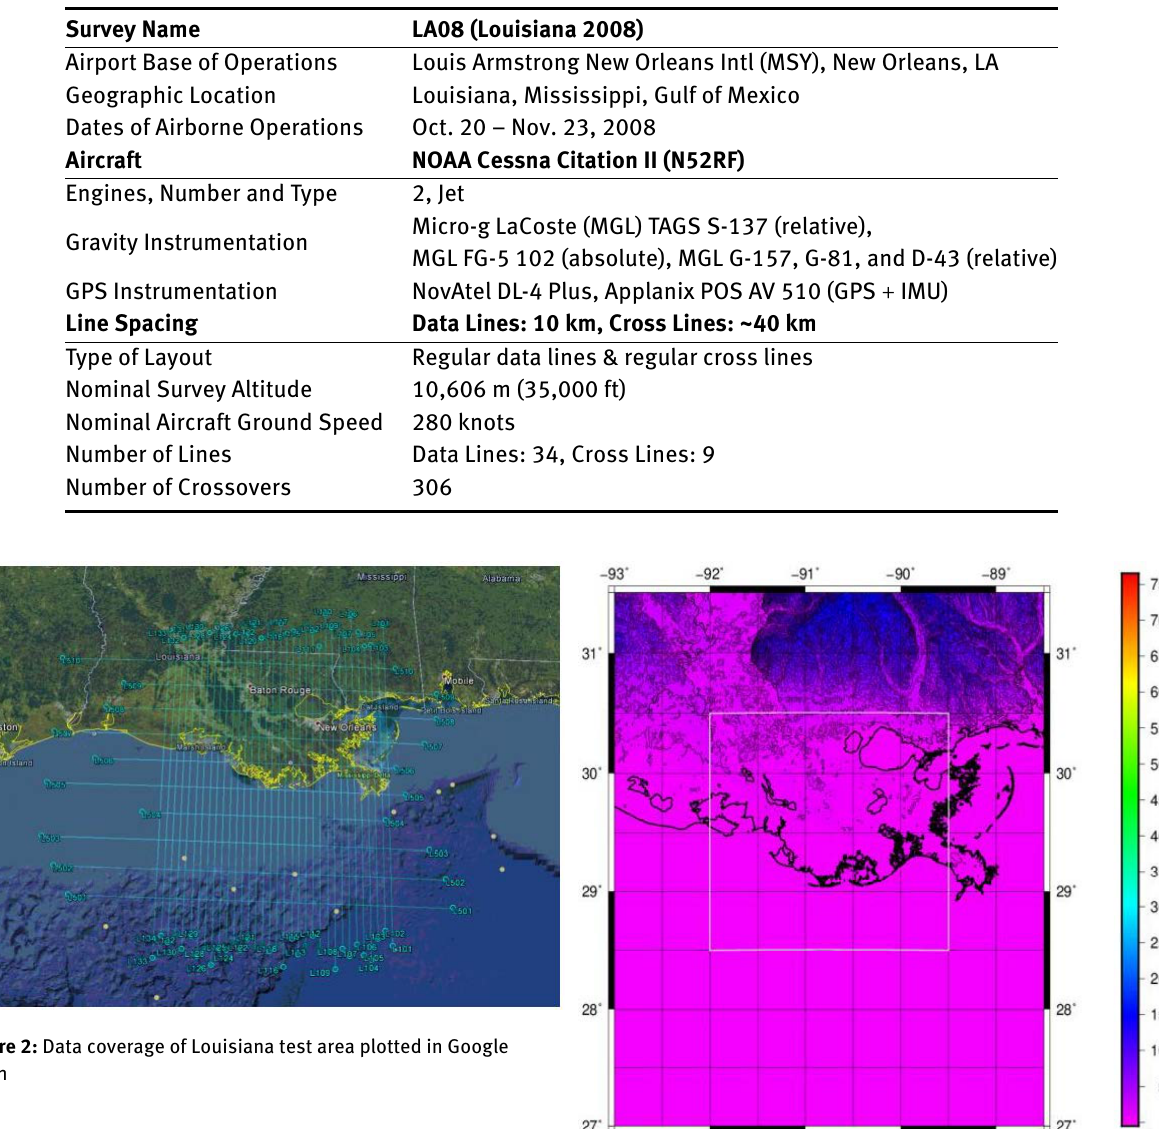
Figure 3: Topographical heights in the Louisiana test area from SRTM 30” data in 10 m contours. The height range within the target geoid area is from 0 to 170